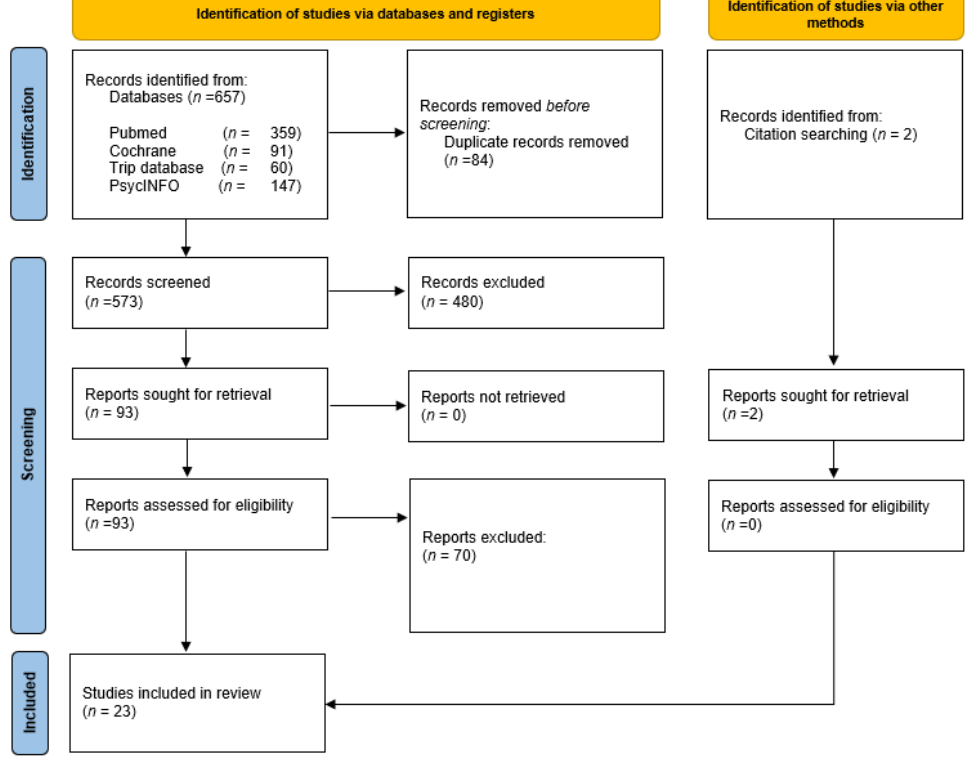
Figure 1. Flowchart of study selection process.